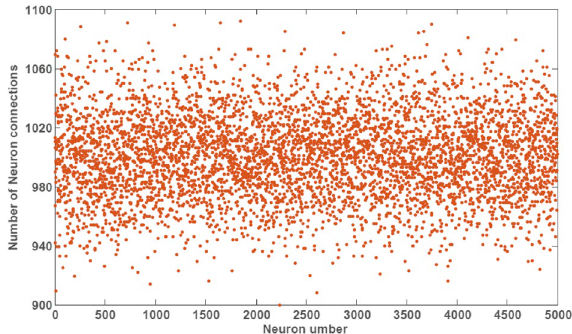
Figure 2. Number of excitatory and inhibitory synapses (connections) for each neuron of digit recognition network. Each point in the figures indicates number of connections (synapses) for the corresponding neuron number on the x-axis.